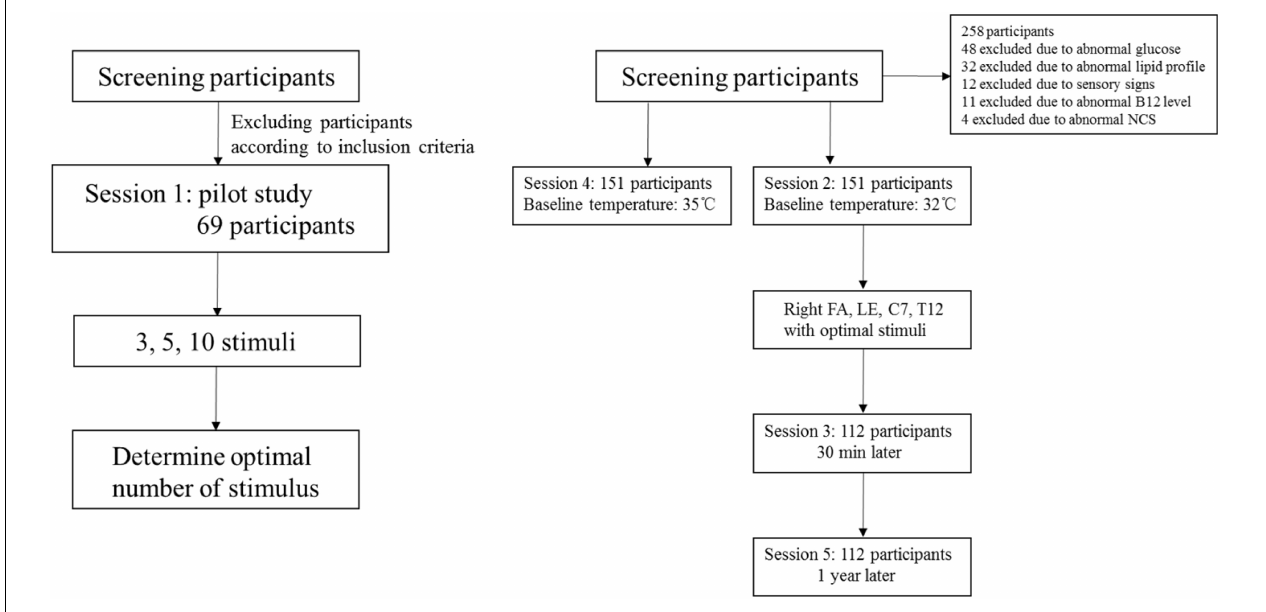
FIGURE 1 | Flow chart of study